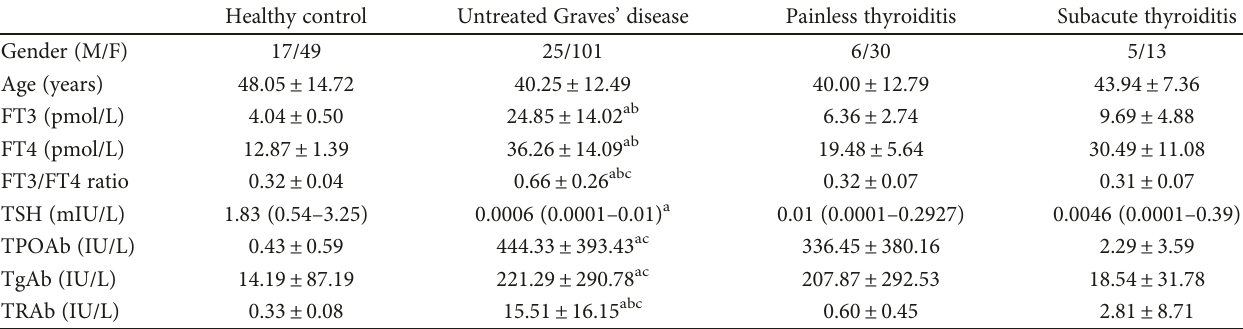
Table 1: Clinical characteristics of the study